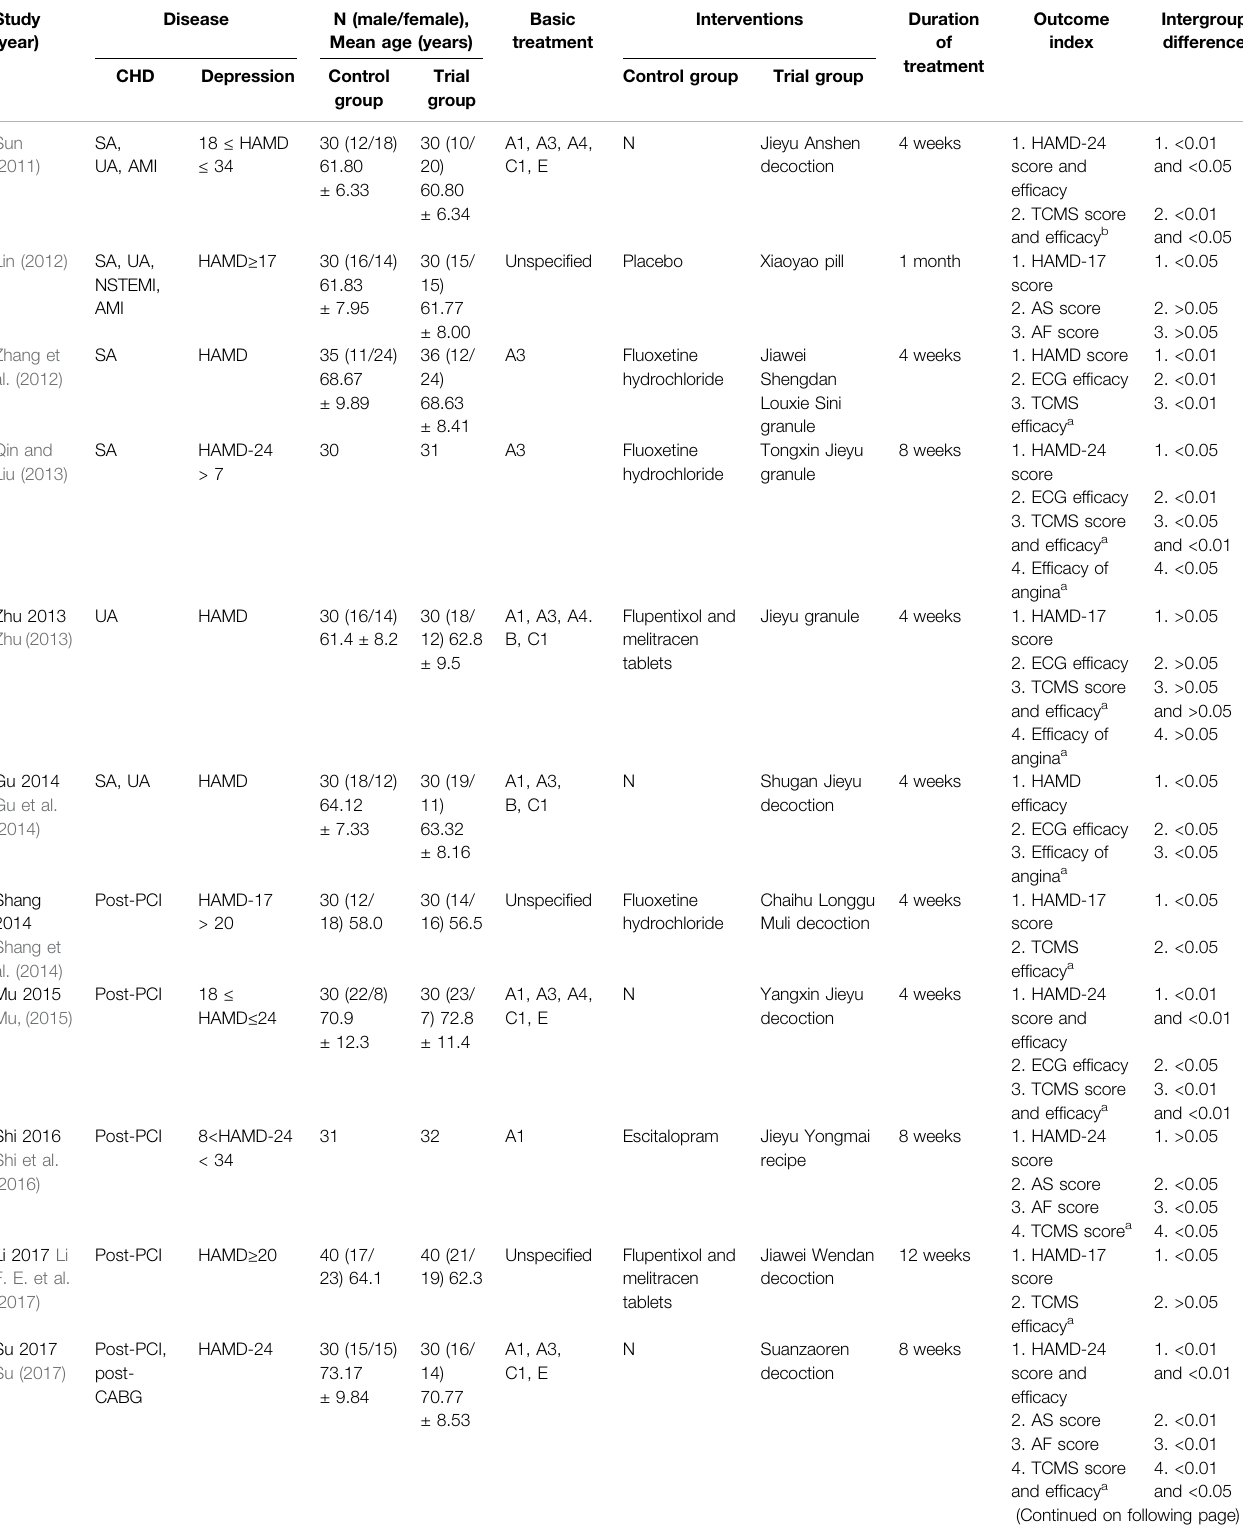
TABLE 2B | Research characteristics of the CHD with